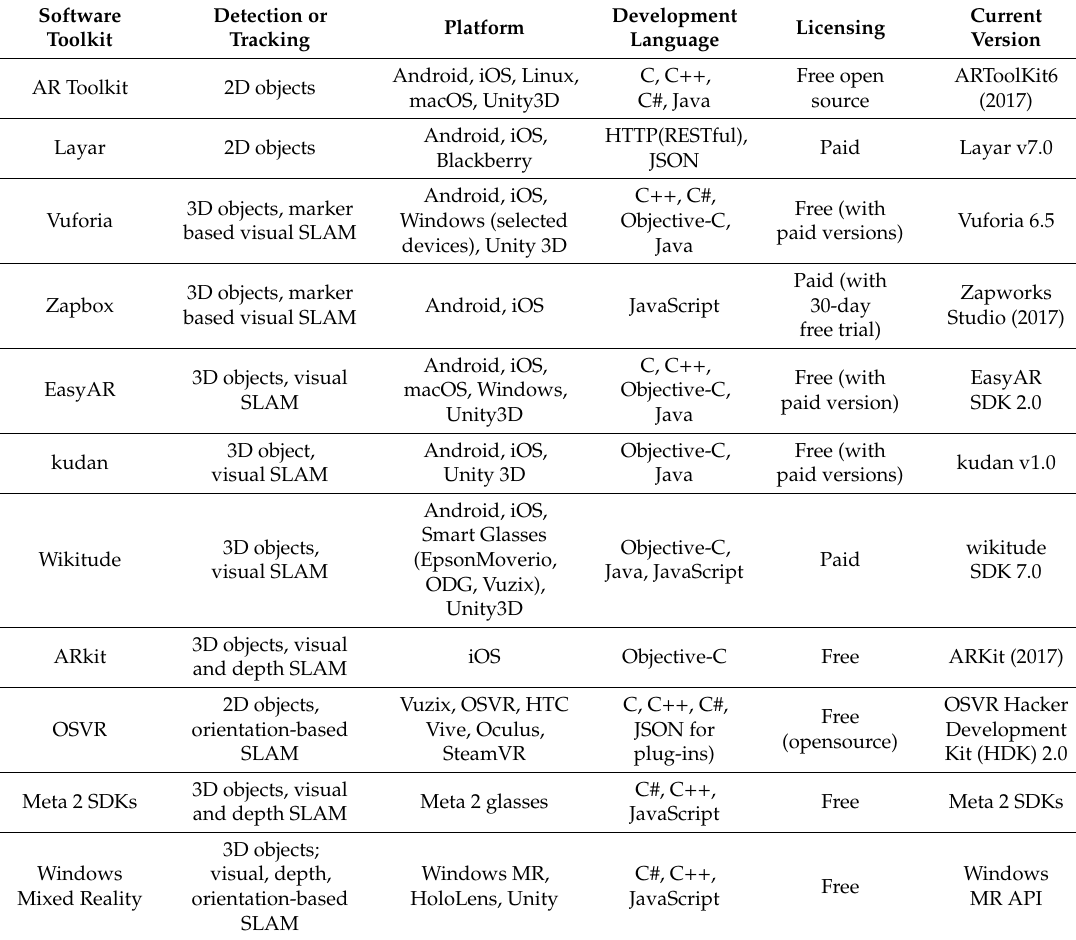
Table 2. MR software, toolkits, and application programming interface